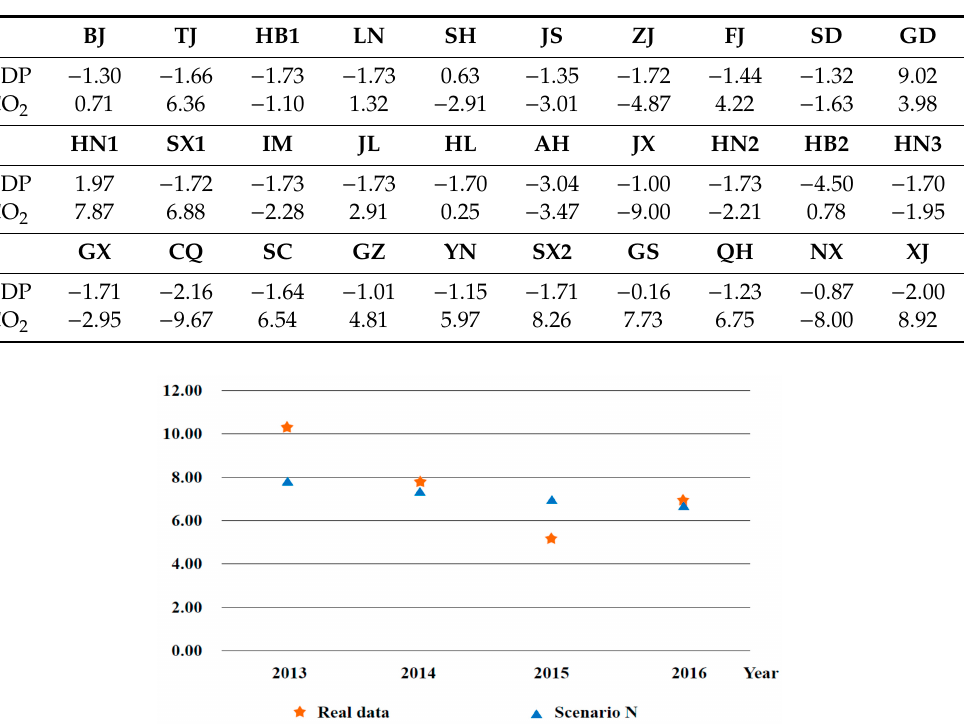
Table 4. Simulation errors for provincial GDP and carbon emissions under scenario N in the base year (%).